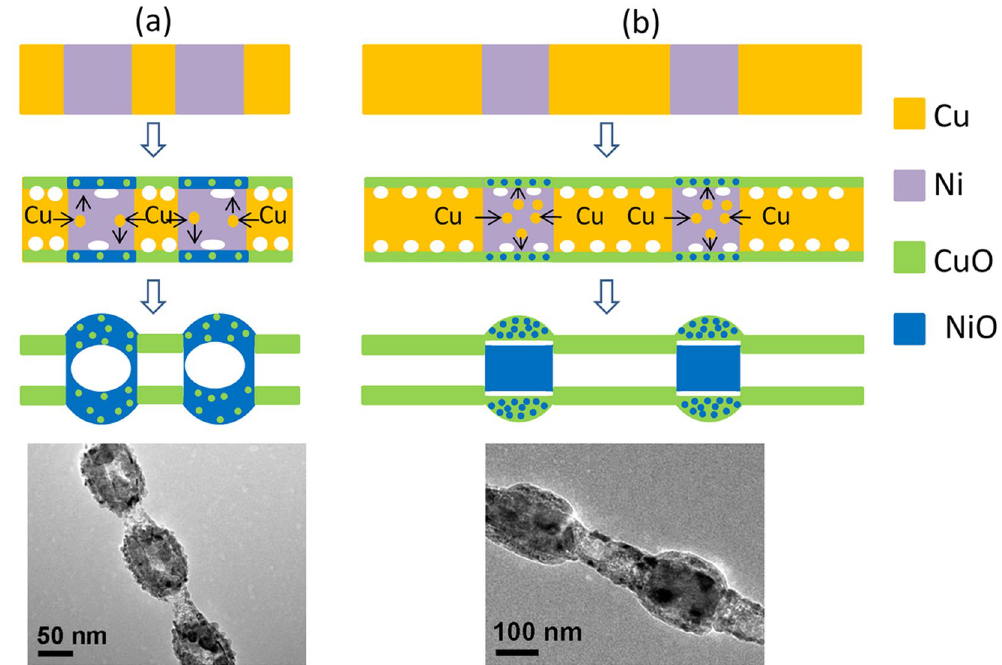
Figure 7. Mechanism analysis. The schematic of the morphology transformation of Ni/Cu nanowires with shorter Cu segment ( a ) and longer Cu segment ( b ) when annealing in